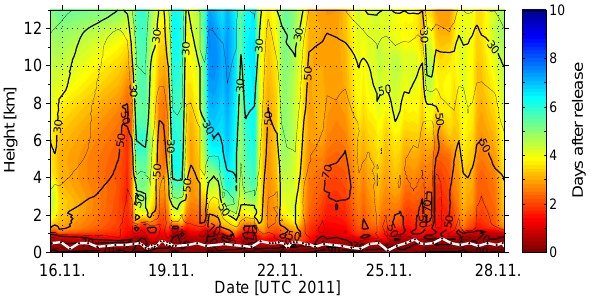
Figure 7. Forward trajectory runs along the cruise track with FLEX- PART using ERA-Interim data. The black contour lines show the mean amount of trajectories (in %) reaching a given height within the specific time (colour shading). The white line indicates the ra- diosonde MABL